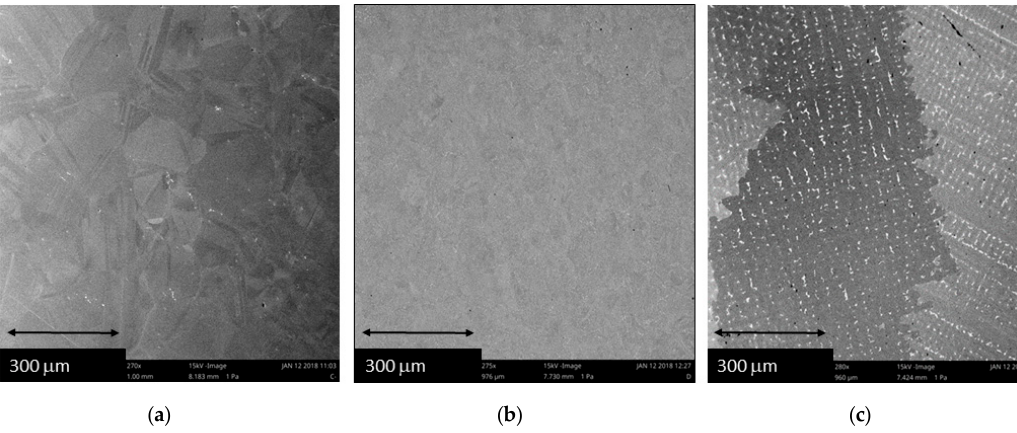
Figure 4. SEM micrographs of different microstructures obtained as a function of the manufacturing method used. ( a ) Computer-aided design and manufacturing (CAD-CAM) milling, ( b ) laser sintering, and ( c ) casting.